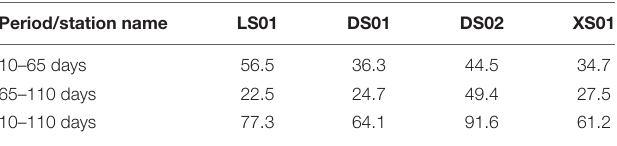
TABLE 2 | Time- and vertical-averaged eddy kinetic energy of three periods (cm 2 /s 2